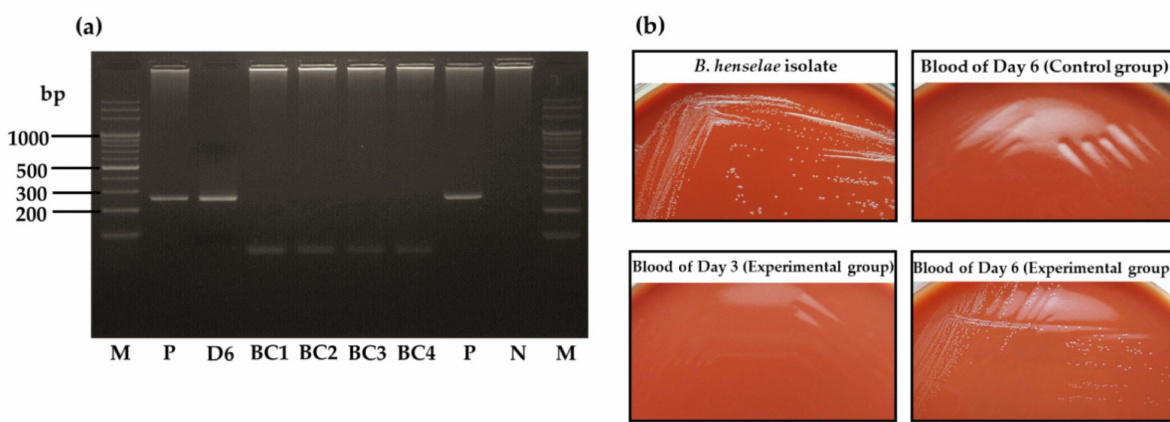
Figure 4. Detection of B. henselae DNA and isolation of B. henselae colonies from daily collected blood samples during feeding of larvae infected at the preceding adult stage through artificial membrane feeding system. ( a ) PCR results of blood sample and bacterial colonies from blood sample of day 6. M, DNA marker; D6, blood sample collected from feeder on day 6; BC1–4, bacterial colonies harvested from chocolate agar plate; P, positive control ( B. henselae DNA); N, negative control (distilled water). ( b ) Isolation on chocolate agar of bacteria from blood samples during 7 days of larval feeding. After 14 days of culture, bacterial colonies of whitish–translucent color were observed only for the blood sample collected on day 6 in the experimental group. B. henselae isolate is shown as a positive control for